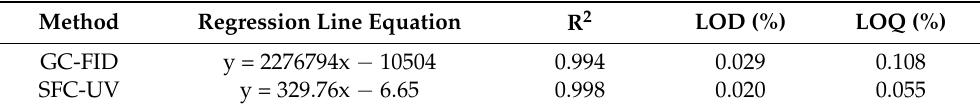
Table 3. Regression line equation, correlation coefficients (R 2 ), and limits of detection (LOD) and of quantification (LOQ) for limonene. Concentration range for was between 4.85 and 0.15 g/100 g for both GC-FID and